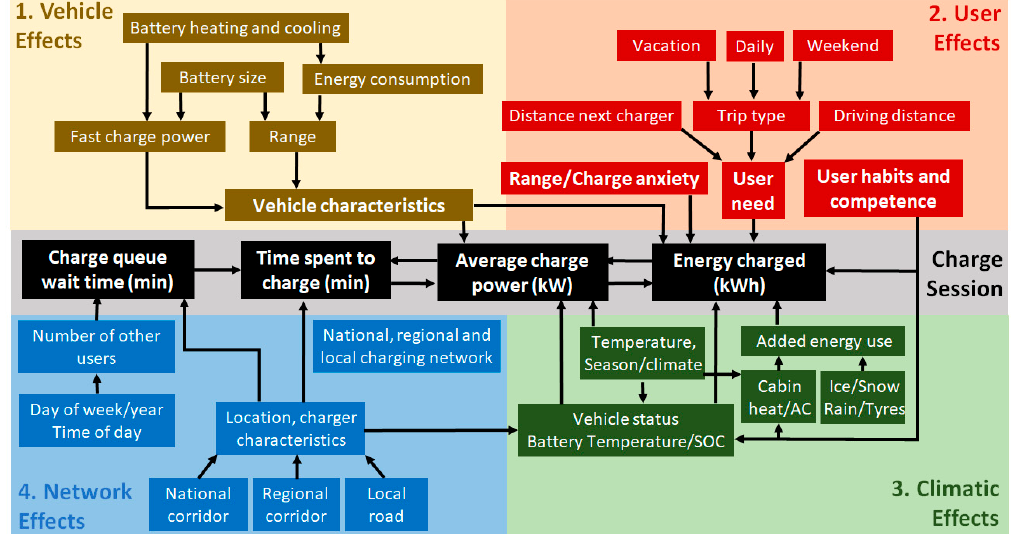
Figure 4. Conceptual framework of the factors that may influence the user experience of fast charging. Black are the main factors that characterizes the overall Charge Session. Yellow / brown are Vehicle factors that cannot be influenced once the vehicle has been bought. Red Factors reflects are the user actions that influences the charging process. Dark green is Climatic Factors that influence charging. Blue are Network Factors that influence the charging process. The overall fast charging usage in Norway will be influenced by the sum of these e ff ects over all users and all sessions. Source: Author.